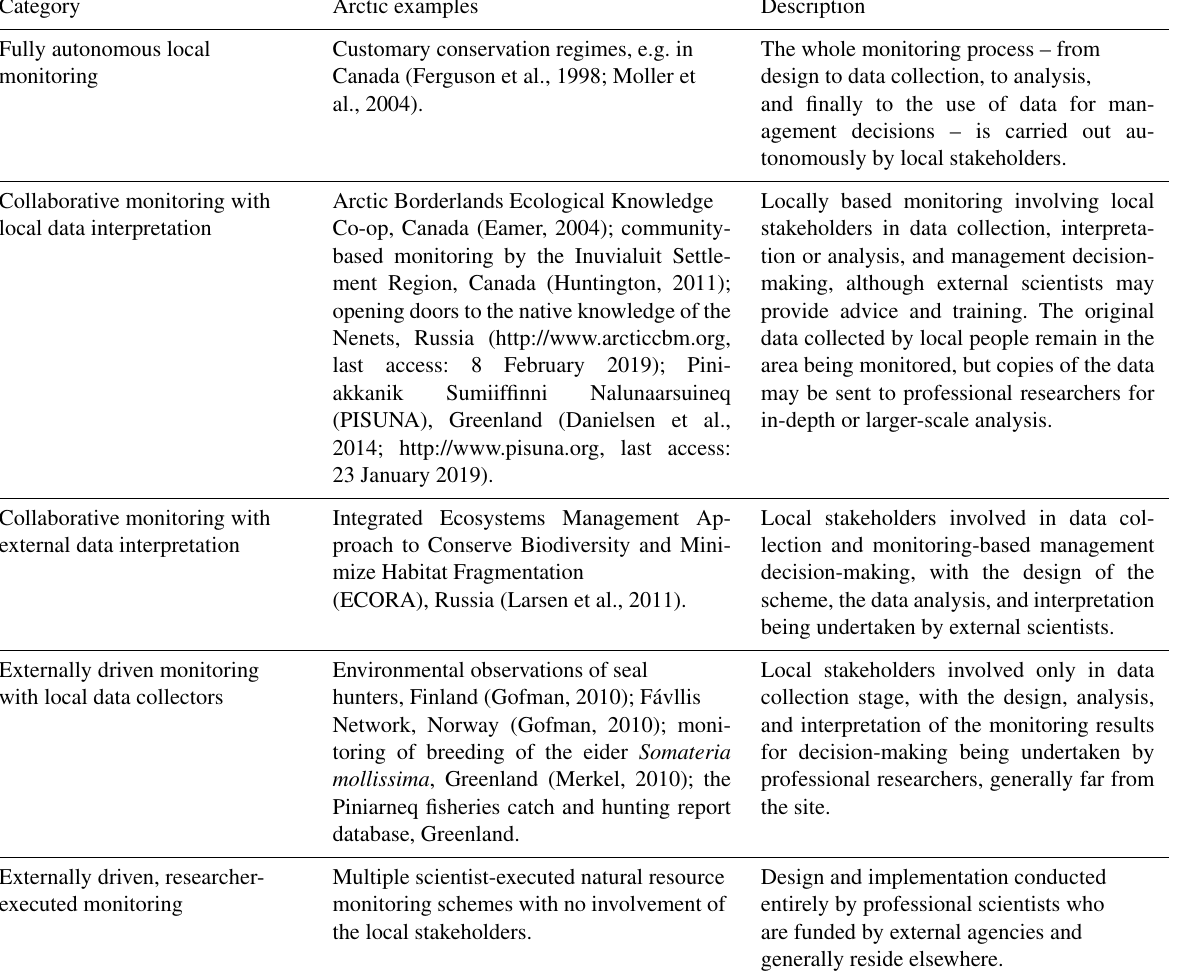
Table A1. Arctic and sub-Arctic natural resource monitoring schemes across a spectrum of possible monitoring approaches based on the relative participation of different actors (modified from Danielsen et al., 2009; Huntington et al., 2013). The relative role of community members in the monitoring systems increases from bottom to top between the five categories of monitoring